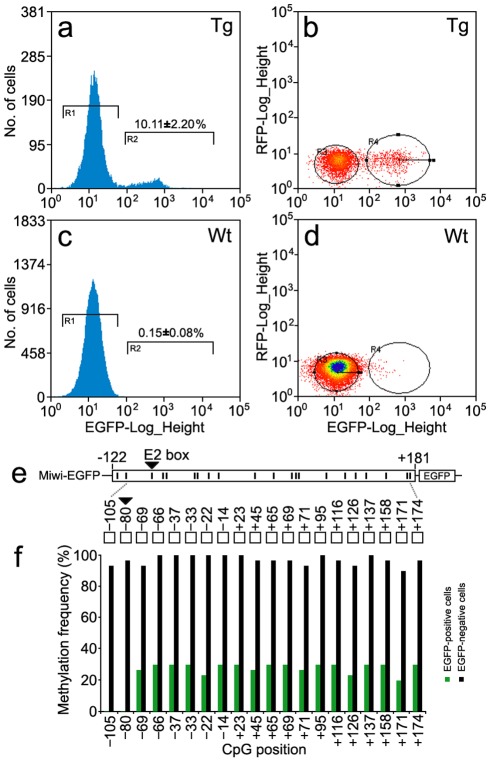
Methylation profile of the Miwi promoter–driven transgene in Miwi-EGFP transgenic mice.a,c), Flow cytometric analysis of male germ cells from heterozygous Miwi-EGFP transgenic mice (a) and wild type (c). Values on the y-axis represent the number of cells, and values on the x-axis represent EGFP fluorescence intensity. The number in the R2 gate represents the percentage of the cells with EGFP fluorescence. The data is representative of three independent experiments. b,d) Flow cytometric separation and collection of EGFP-positive male germ cells from Miwi-EGFP transgenic mice (b) and wild type mice were used as a control (d). Values on the x-axis represent EGFP fluorescence intensity, and values on the y-axis represent red fluorescence intensity. The cell population in the R4 gate shows clear EGFP fluorescence in panel b. e). The positions of 20 CpG dinucleotides within the promoter region of the Miwi-EGFP transgene. f). Comparison of methylation frequencies along the CpG positions between EGFP-positive cells and EGFP-negative cells from the Miwi-EGFP transgenic mouse testis. The CpG dinucleotides in the E2 box (−80) were hyper-methylated (96%) in the EGFP negative cells, however, the CpG in the same position were completely un-methylated in the EGFP-positive cells.